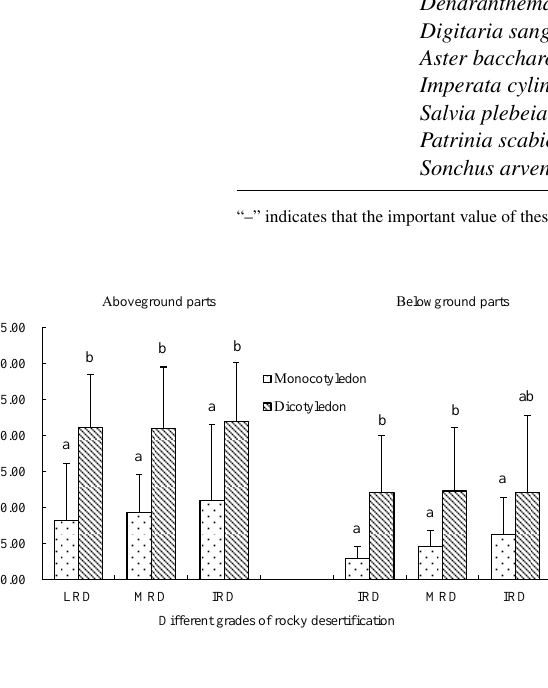
Figure 4. Ca content in the aboveground and belowground parts of different plant types from three different rocky desertification sam- ple areas. LRD: light rocky desertification; MRD: moderate rocky desertification; IRD: intense rocky desertification. Values with the same letters were not significantly different ( p> 0 .